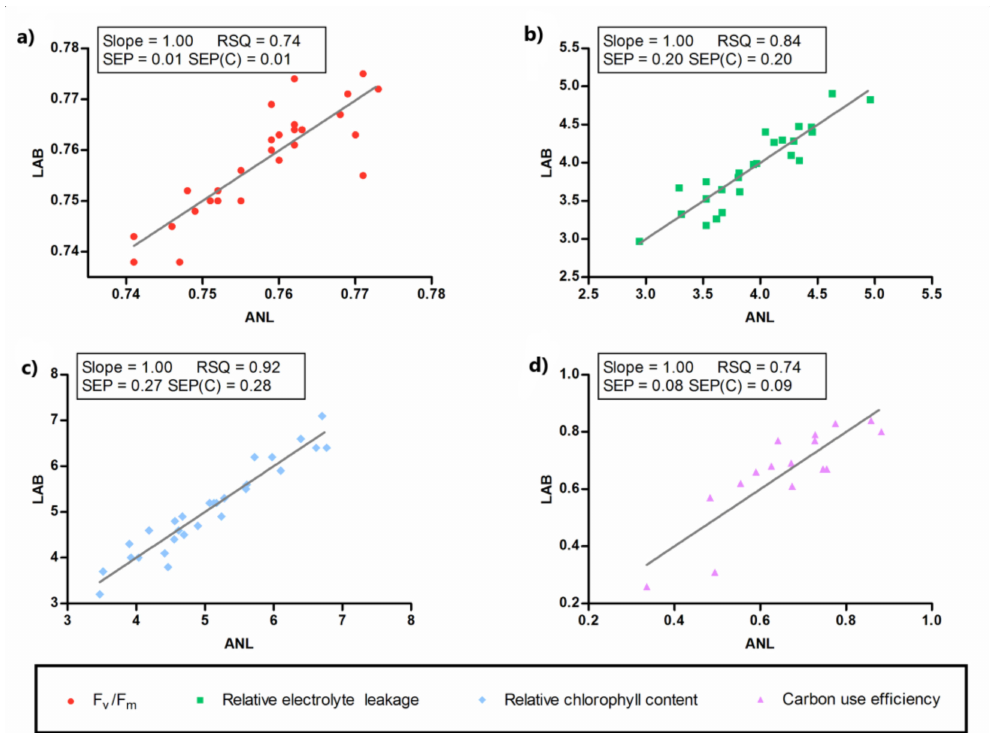
Figure 7. Comparison between the predicted data (ANL) and the data obtained experimentally (LAB) for the reference variables. ( a ) Fv / Fm; ( b ) Relative electrolyte leakage; ( c ) Relative chlorophyll content; ( d ) Carbon use e ffi ciency. RSQ, coe ffi cient of determination; SEP, standard error of prediction (internal validation); SEP(C), standard error of prediction corrected for the